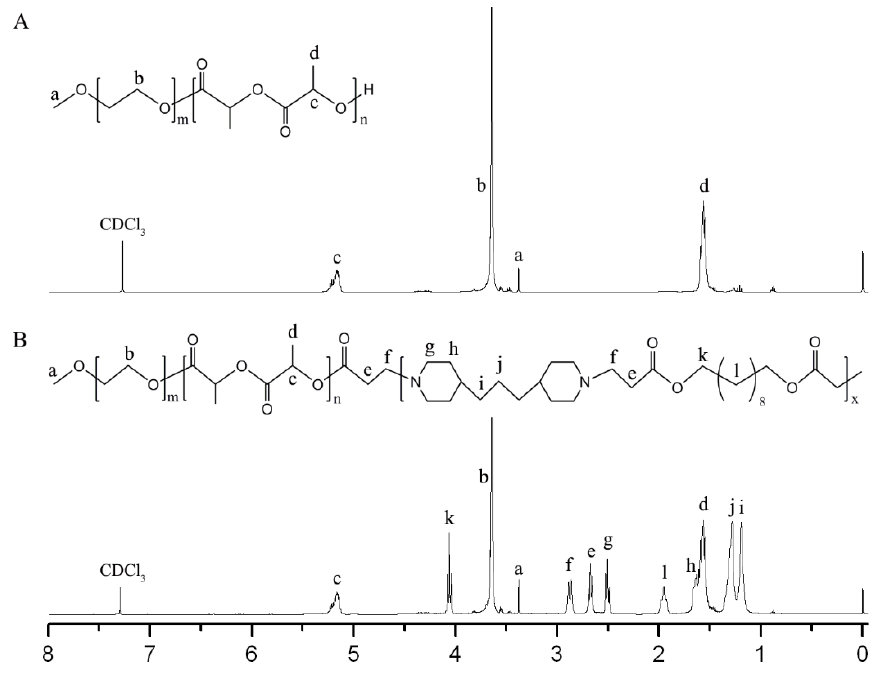
Figure 2. 1 H NMR spectra of ( A ) MPEG ‐ PLA and ( B ) MPEG ‐ PLA ‐ PAE. CDCl 3 was used as the